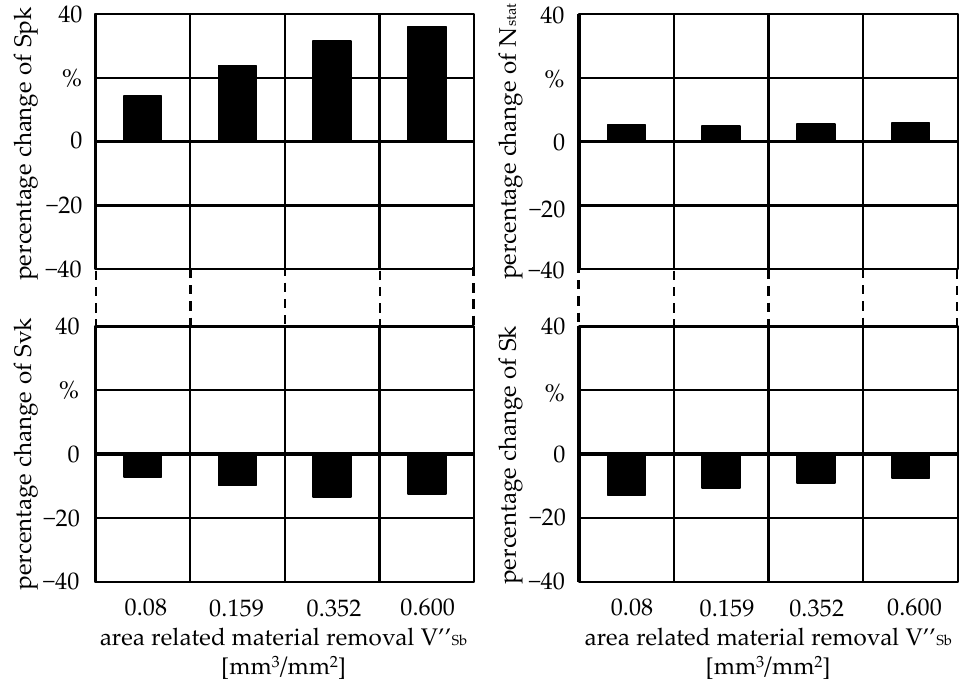
Figure 12. Influence of the area-related material removal V’’ Sb on the topography characteristics. Figure 13 illustrates the grinding forces depending on the area-related material re- moval in sharpening V’’ Sb . The resetting of the bond material results in a rough grinding wheel topography and thus in a reduction in the grinding forces.